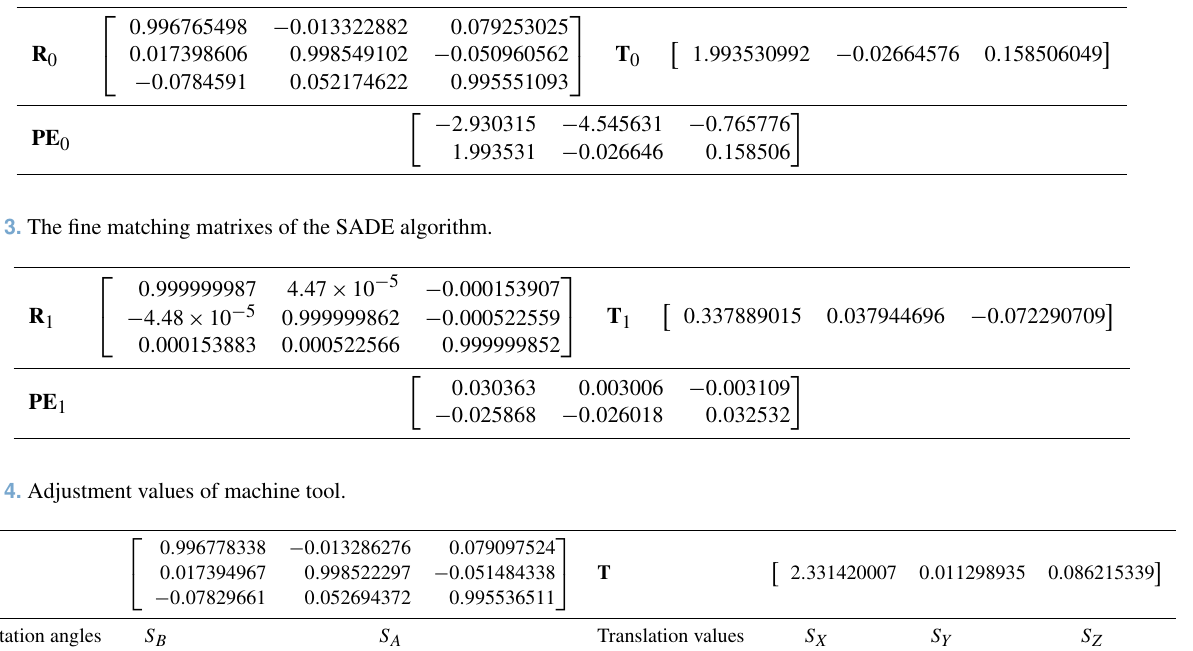
Table 2. The rough matching matrixes.